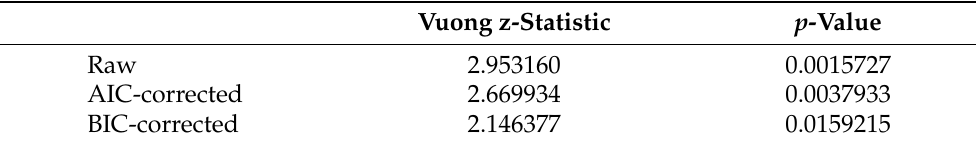
Table 7. Results of the Vuong test-ZI negative binomial x negative